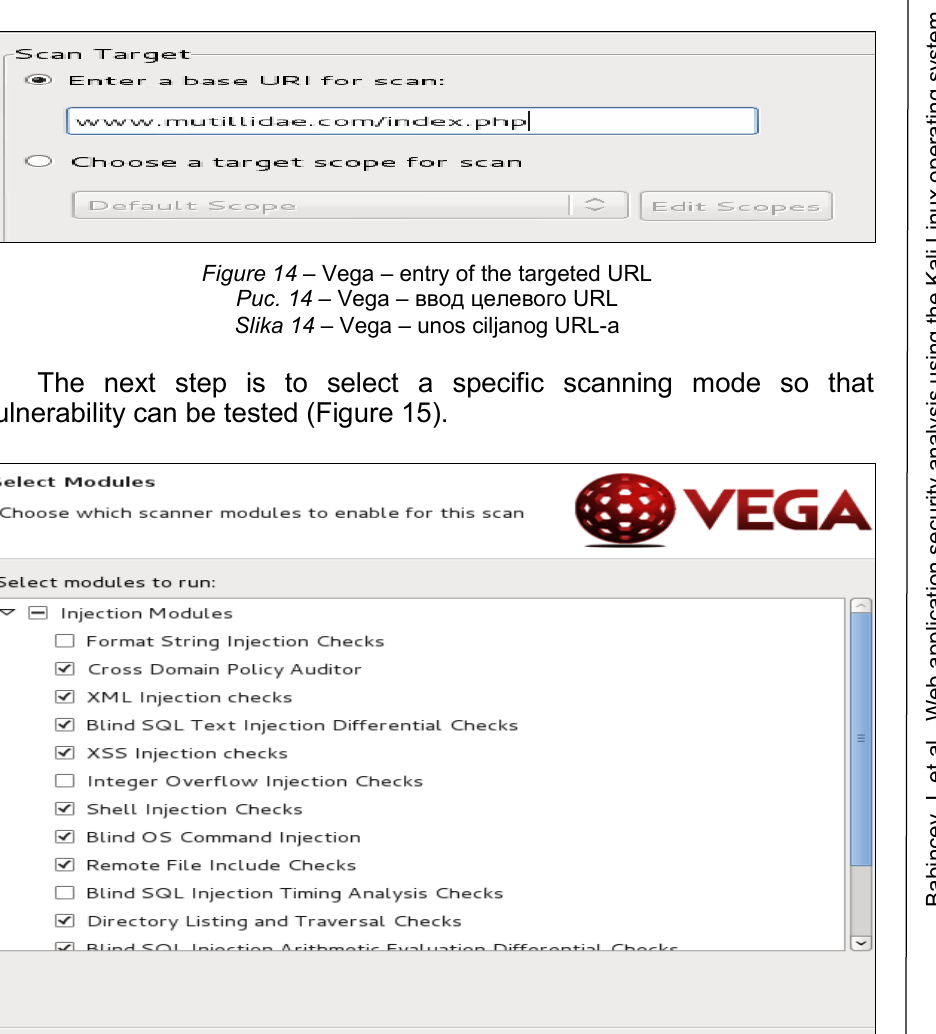
Figure 15 – Vega - ways of scanning Рис . 15 – Vega – способы